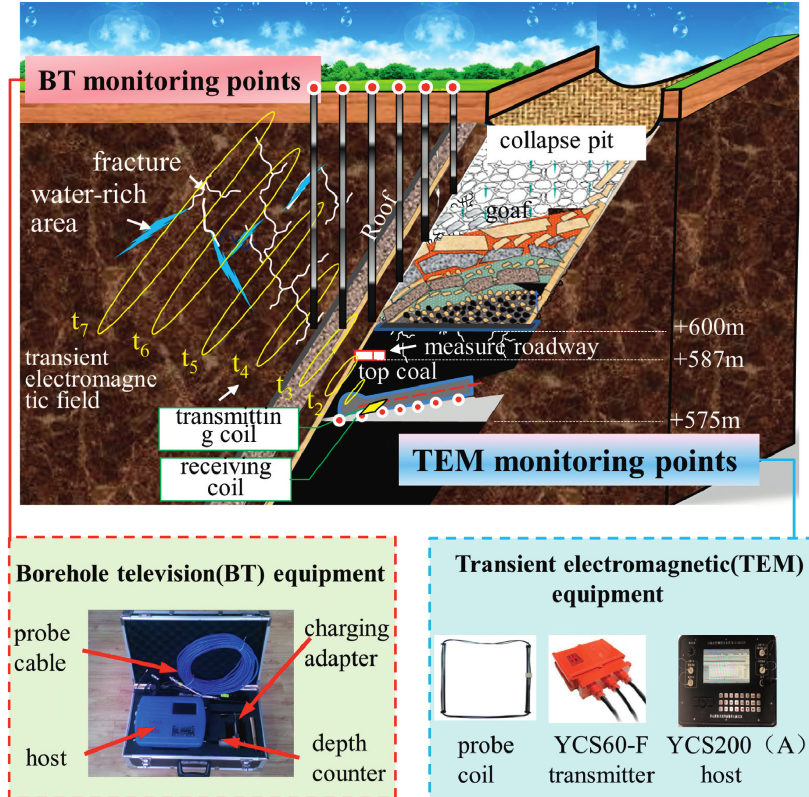
Figure 5: BT-TEM detection area and